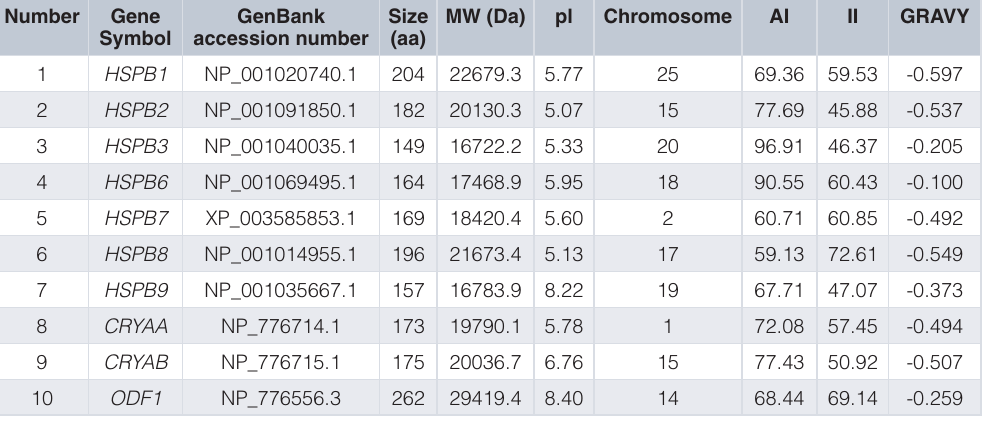
Table 1. Biochemical characterization of the bovine small heat shock protein genes.